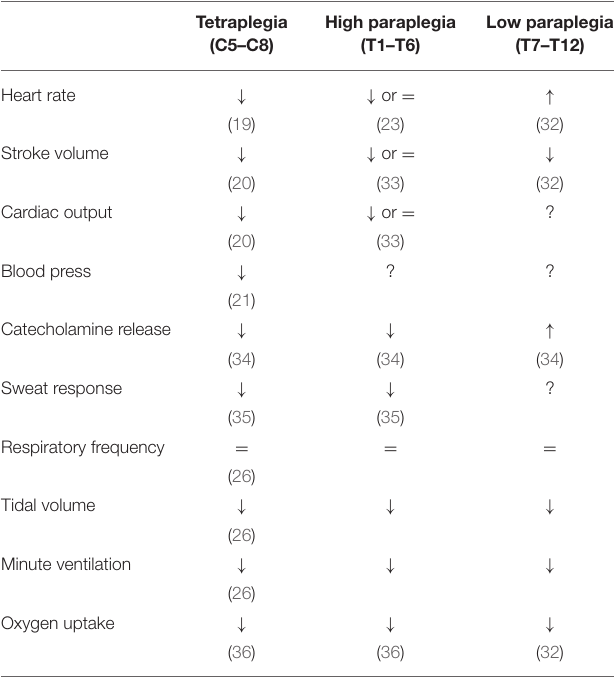
TABLE 1 | Peak physiological responses to arm exercise following complete spinal cord injury relative to able-bodied